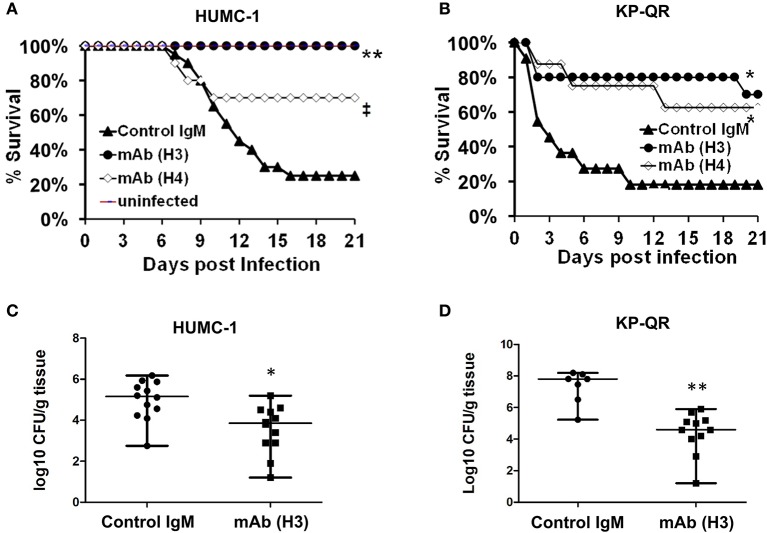
Monoclonal antibody (mAb) clones H3 and H4, targeting Hyr1 peptide #5, protect mice from HUMC-1- or KP-QR- induced pneumonia. Immunosuppressed CD-1 male mice (n = 10/group from two experiments) were infected with HUMC-1 via inhalation [average 5 × 1010 colony-forming units (CFU)] (A). Immunocompetent mice (n = 10/group from two experiments) were infected intratracheally with KP-QR (average 3.4 × 107 CFU) (B). Intraperitoneal (i.p.) treatment with mAb H3, H4, or isotype-matched control IgM started 24 h and repeated at 96 h post infection (30 μg/mouse each dose). *P < 0.05, P = 0.06, and **P < 0.001 vs. control IgM by log-rank test. For CFU measurement, H3 and control IgM were administered 6 h and 3 days post infection, and lungs harvested from mice at Day +4 (for HUMC-1) (C) and at Day +2 (for KP-QR) post infection (D).